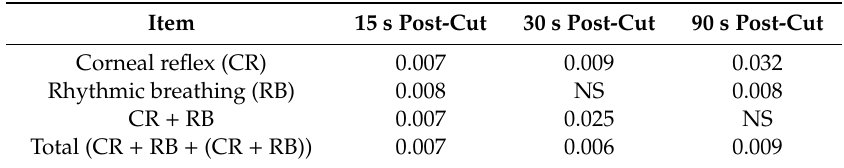
Table 2. Significance level between the two groups of animals slaughtered following traditional slaughtering ( n = 120) or Halal religious rite ( n =